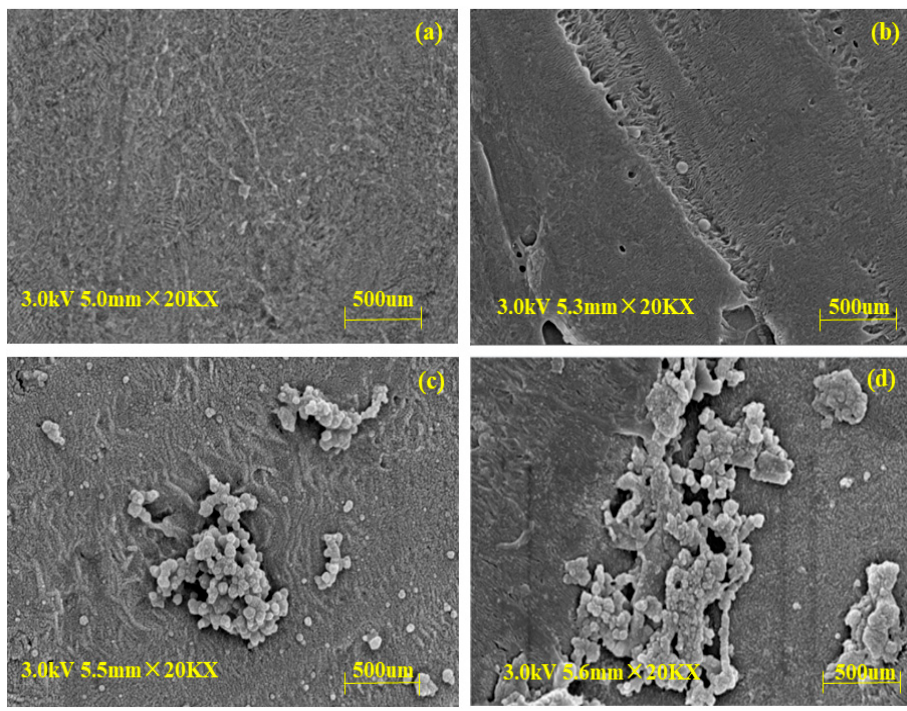
Figure 11. SEM images of BLIMs: ( a ) PES membrane, ( b ) CAL-B@PES, ( c ) CAL-B@PDA/PES, and ( d ) GA/CAL-B@PDA/PES, after esterification.